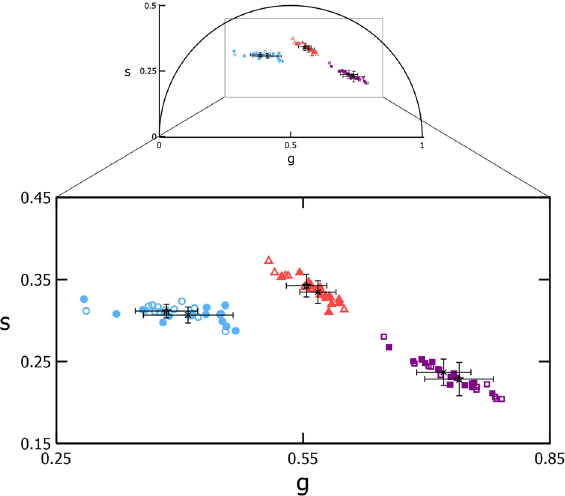
Figure 3. The phasor coordinates of photoreceptor classes between imaging exposures. Phasor plot with inset comparing the average phasor coordinate of the two clusters of cones (blue circles and red triangles) and one cluster of rods (purple squares) identified for 15 locations (in 3 monkeys) each imaged on two different days (filled—Day 1; open—Day 2). For each cluster, the error bars show the standard deviation of the phasor coordinates for each day (X—Day 1; star—Day